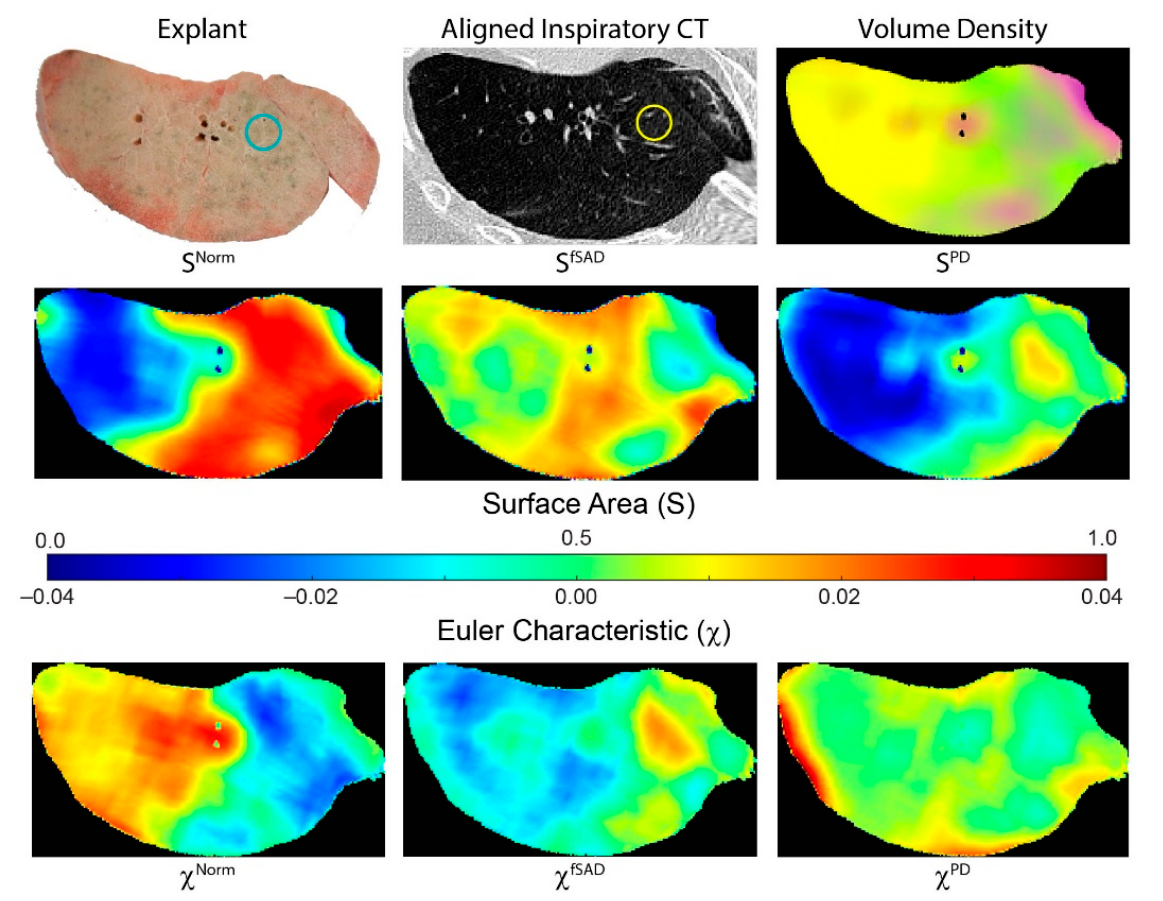
Figure 3. Representative case illustrating spatial heterogeneity in tPRM measures. Presented is a photo of an explanted lung section, with corresponding aligned inspiratory CT scan and tPRM-derived volume density map, surface area and Euler–Poincaré characteristic. Volume density map depicts the local extent of normal parenchyma (green), fSAD (yellow) and PD (magenta). Surface area and Euler–Poincaré characteristic are provided for each PRM classification. The circles on explant (blue) and CT (yellow) provide approximate location and size of an example core sample. This case is a male diagnosed with BOS 447 days post-transplant. This patient had a FEV1pp of 18% and FEV1/FVC of 0.41 when undergoing redo transplantation.